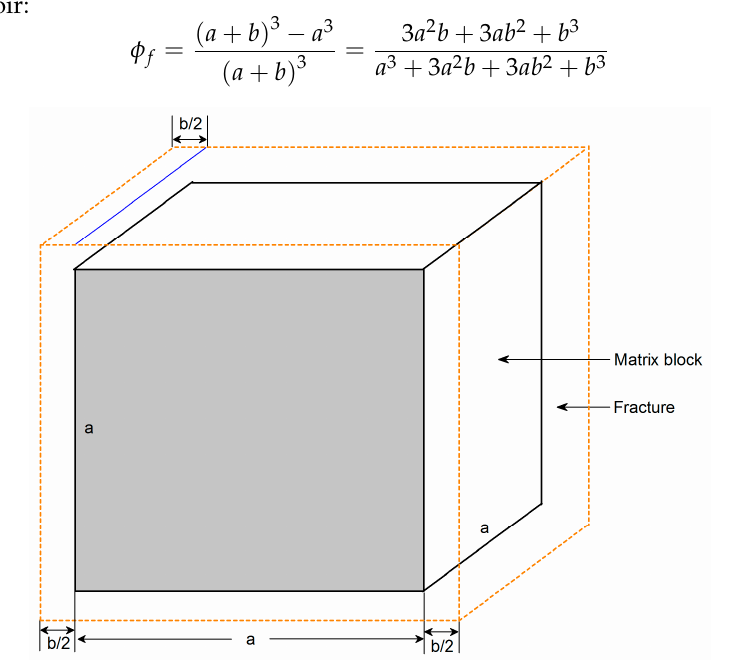
Figure 2. Fracture porosity definition in a naturally fractured reservoir.